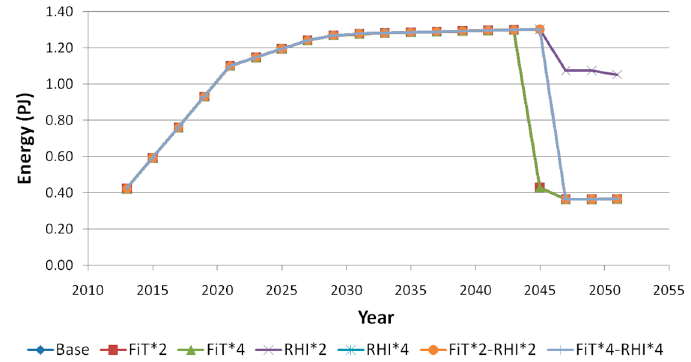
Figure 14. LFA farms—biogas production.